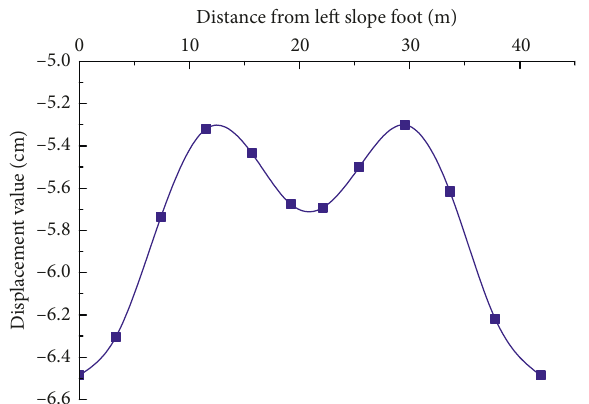
Figure 17: Recompression displacement diagram after backfilling.